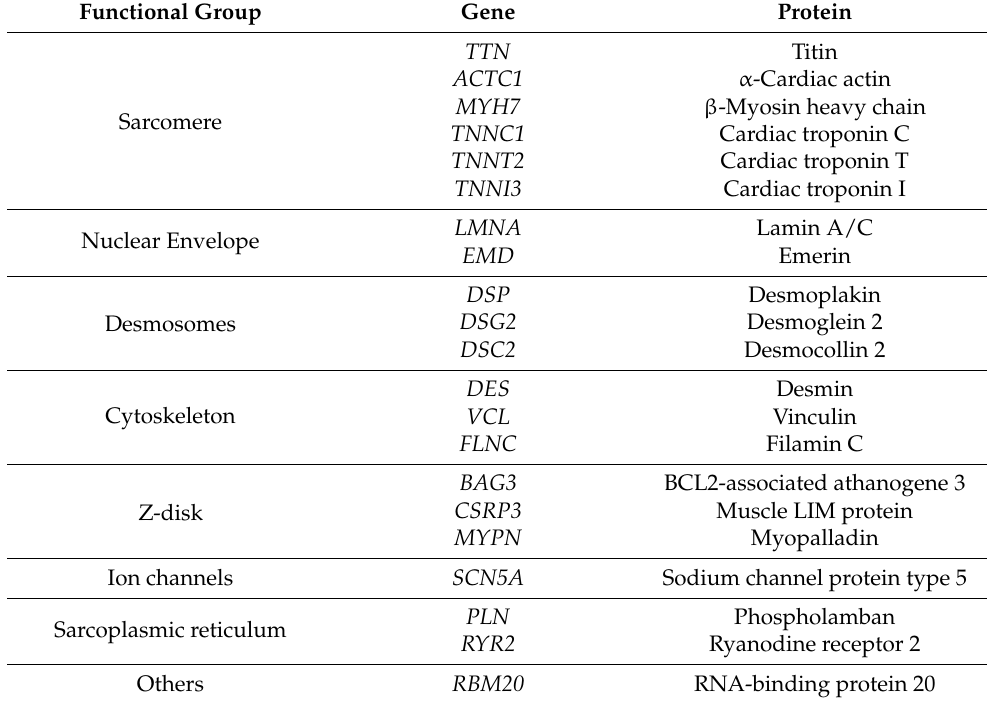
Table 1. Representative causative genes of dilated cardiomyopathy. Functional